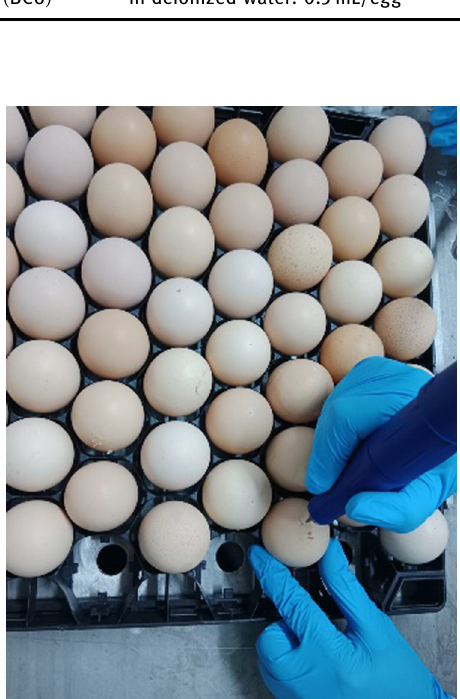
Figure 1: In ovo injection application.